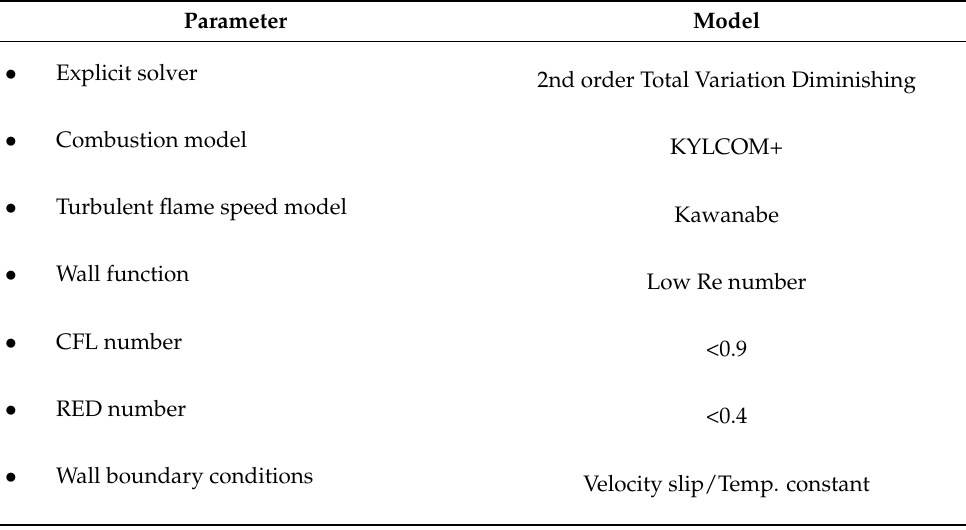
Table 1. Proposed COM3D Analysis Methodology for the Hydrogen Flame Acceleration